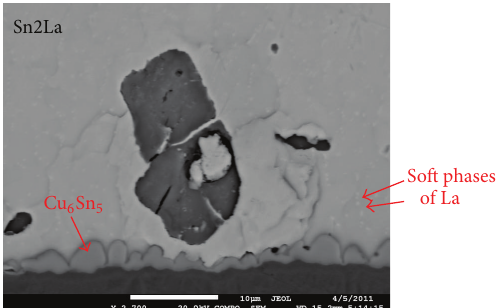
Figure 20: Fine arches of intermetallic Cu 6 Sn 5 phases and incidental greater oxidised La phase in tin matrix of Cu/Sn2La joint.